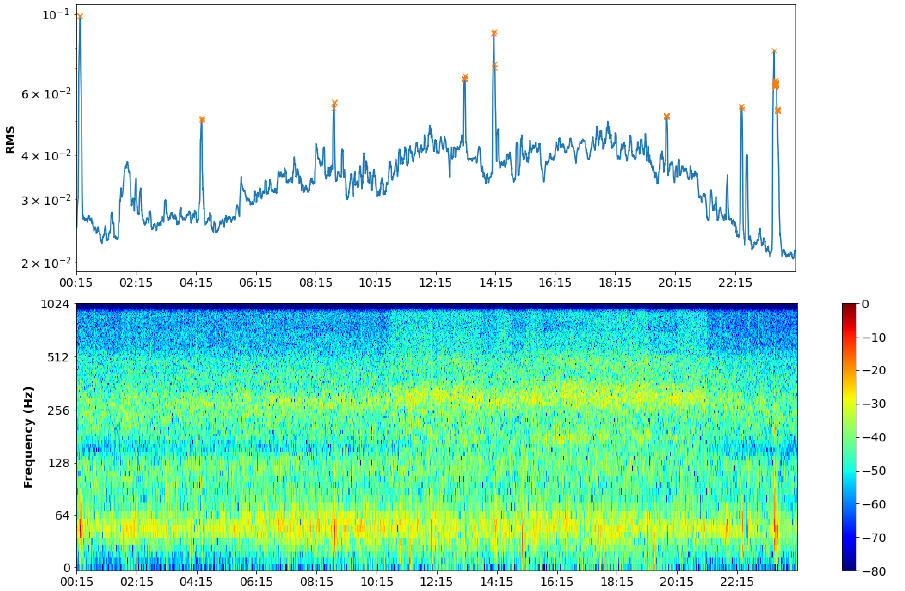
Figure 4. RMS curve and corresponding spectrogram for a hive with with 3 full boxes of bees (12 August